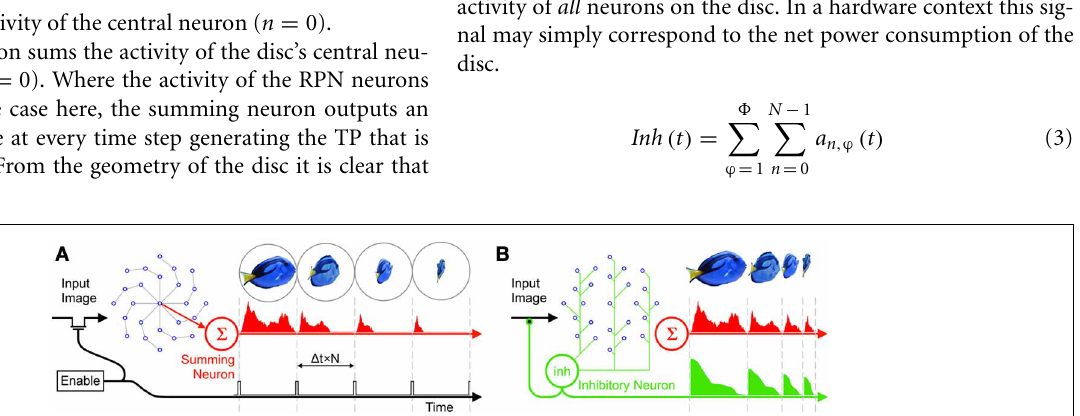
FIGURE 4 | Two frame generation approaches: (A) A periodic enable signal projects new frames on to the RPN, (B) the inhibitive neuron is connected to all neurons on the disc. As the disc activation collapses inward along the arms and leaves the disc via the summing neuron, the total activation reaching the inhibitive neuron also falls. Once the disc activation reaches zero, the path of the input image is unblocked allowing